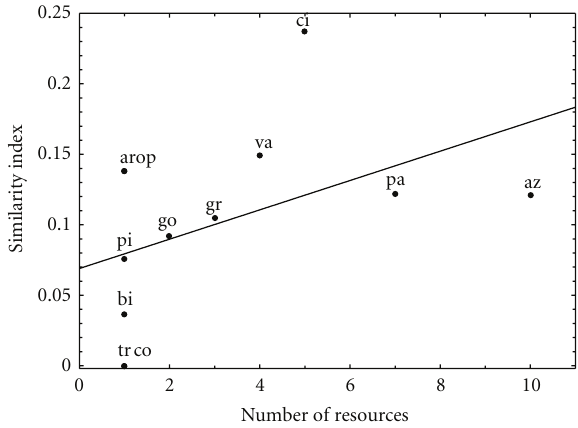
Figure 3: Relationship between the total number of plant resources used by Merosargus species and the average number of shared resources found in samples collected at the Parque Estadual do Rio Doce (PERD), Minas Gerais, Brazil, between October 2001 and October 2004. Ar- M. arcuatus ; az- M. azureus ; bi- M. bivittatus ; ci- M. cingulatus ; co- M. coxalis ; go- M. gowdeyi ; gr- M. gracilis ; op- M. opaliger ; pa- M. pallifrons ; pi- M. pictipes ; tr- M. transversus ; va- M. varicrus .